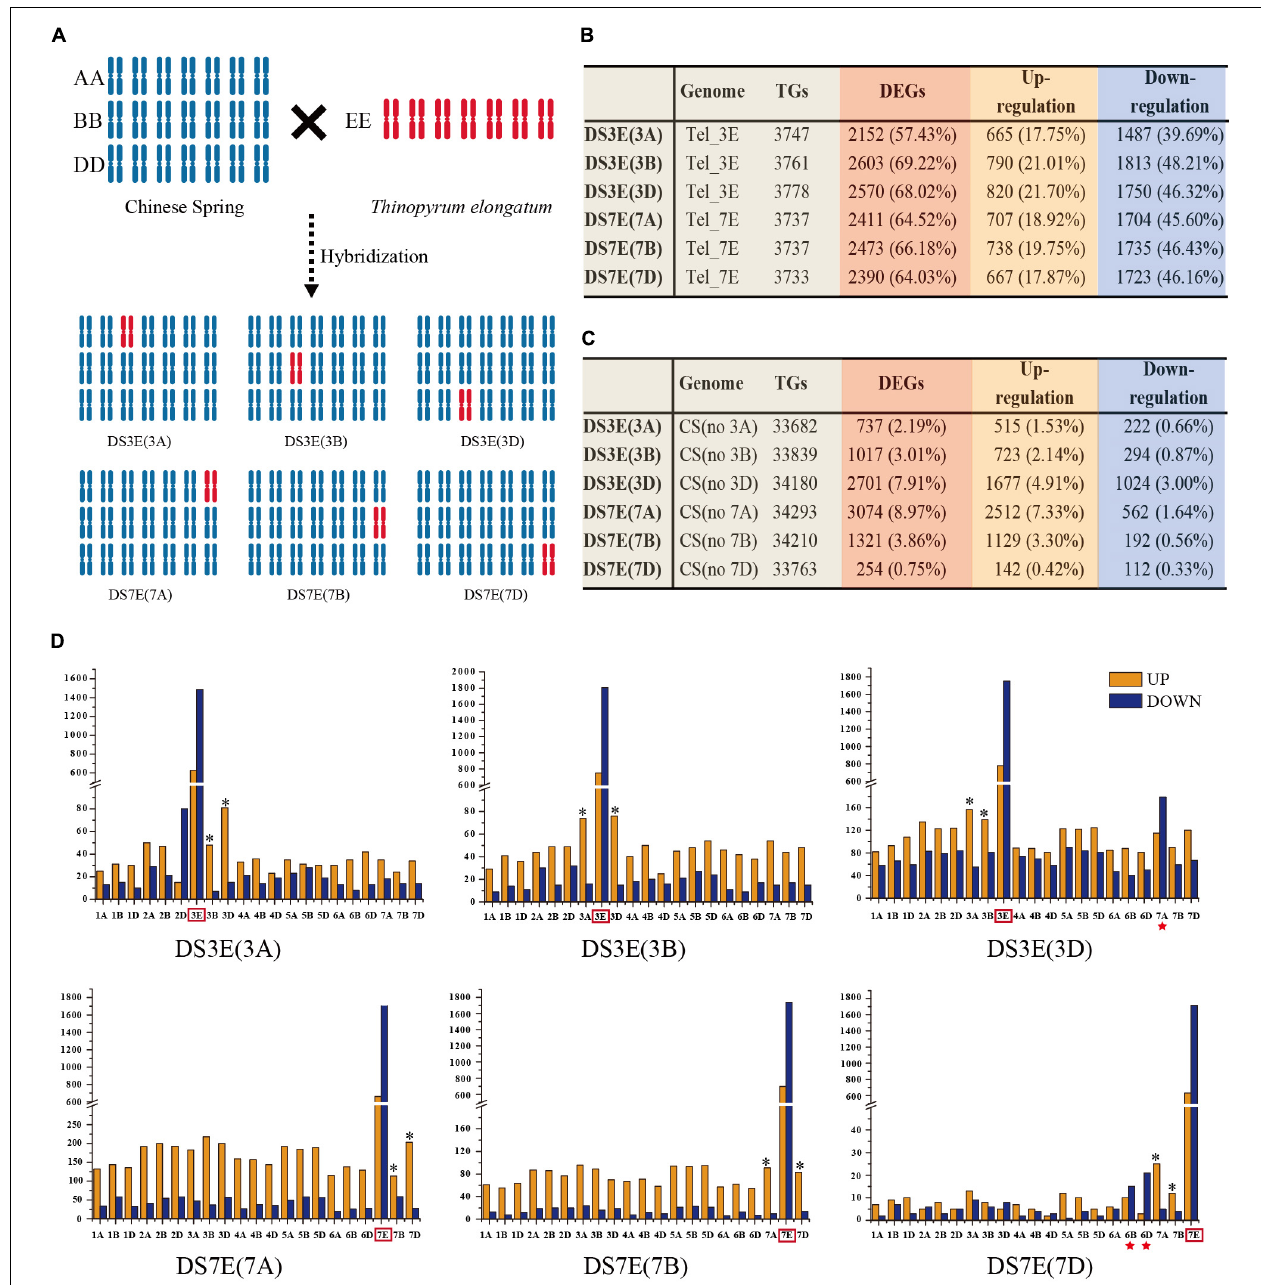
FIGURE 1 | Detailed information on the differential expression of the transcriptome of the substitution line. (A) Schematic diagram of disomic substitution lines produced by distant hybridization between CS and Tel. (B) The differential transcription of Tel genes. (C) The differential transcription of CS genes. (D) Number of differentially expressed genes (DEGs) in alien Tel chromosome and CS genome. The alien Tel chromosome was surrounded by the red box. Homologous chromosomes from CS that belong to the same linkage group as the alien Tel chromosome were marked with an asterisk (*). The upregulated and downregulated genes were represented by the orange and blue rectangles. The chromosomes with missing fragments were marked in a red